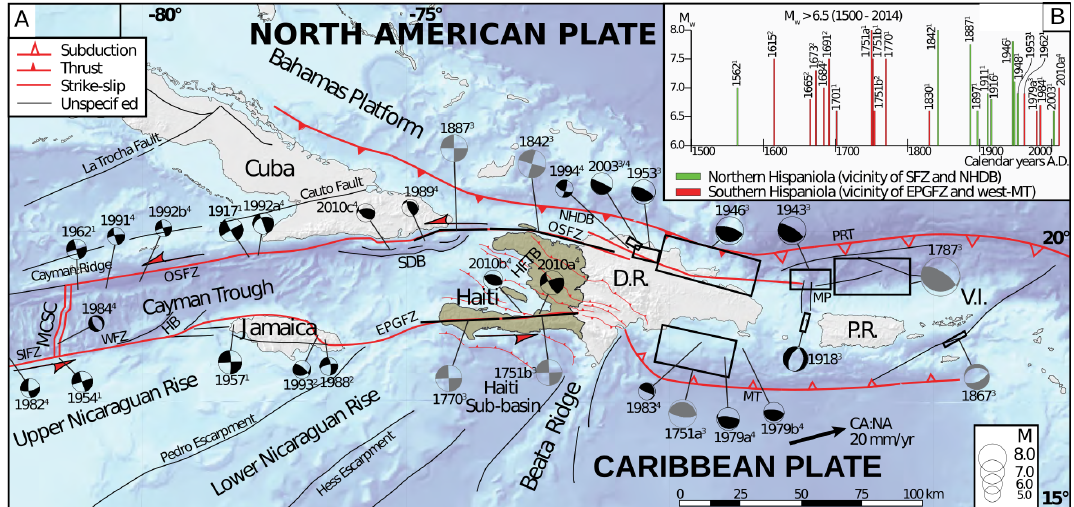
Figure 2. Historical earthquakes along the Caribbean Plate northern boundary. (a) Selection of historical and recent earthquakes. Focal mechanisms in gray are historical ( M w > 7 . 0; pre-1900) earthquakes, and focal mechanisms in black are recorded earthquakes ( M w > 5; post-1900). Sources: Van Dusen and Doser (2000), Wiggins-Grandison and Atakan (2005), Ali et al. (2008), and the International Seismo- logical Centre (2014; M w > 5; 1976–2014). (b) Earthquakes of M w > 6 . 5 in northern Hispaniola between 1500 and 2016. Earthquakes, in green, from northern Hispaniola and possibly linked to the offshore OSFZ and subduction at the NHDB. Earthquakes, in red, from southern Hispaniola and possibly linked to the EPGFZ or underthrusting at the MT. Sources: McCann (2006), ten Brink et al. (2011), with magnitude on intensity scale (Mi), International Seismological Centre (2014; National Earthquake Information Service – NEIS), and International Seis- mological Centre (2014; global centroid-moment-tensor – GCMT). Note the magnitude difference for event 1751b between McCann (2006) and ten Brink et al. (2011). Modified from Wessels (2019); same notation as Fig.